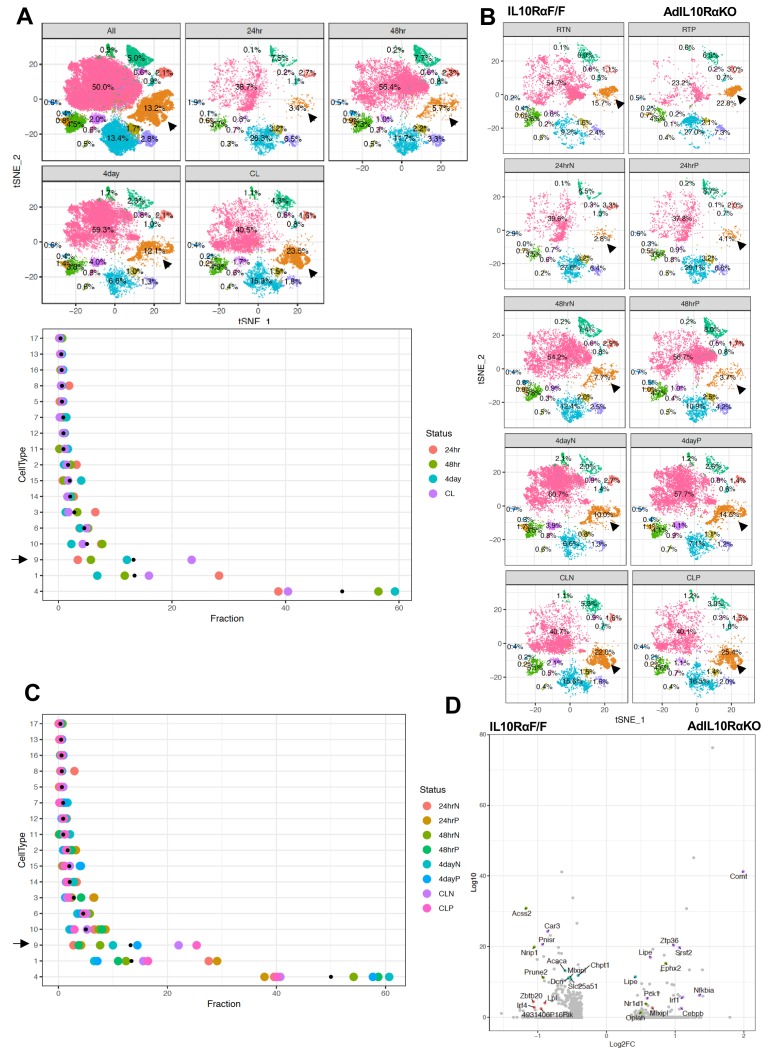
Enrichment of the thermogenic adipocyte cluster in IL10Rα-depleted mice.(A) Top: tSNE-plot showing percentage of clusters from aggregated (All) or from indicated treatments. Bottom: Colored dot plot showing percentage of fractions plotted in y-axis and cell types in x-axis under indicated conditions. (B) tSNE-plot showing differences in percentage of clusters between adipocytes from iWAT from control and AdIL10Rα KO mice under RT, 24 hr, 48 hr or 4 days cold exposure, or CL treated conditions. (C) Colored dot plot showing percentage of fractions plotted in y-axis and cell types in x-axis under indicated conditions and genotype. N deonotes Adipoq-Cre-Negative IL10RαF/F (IL10RαF/F) and P denotes Adipoq-Cre-Positive (AdIL10Rα KO) mice. (D) Volcano plot showing adipocyte gene expression differences between indicated mice from cluster 9. The Log2Fold Change (FC) ratio of floxed control vs. AdIL10Rα KO was plotted as a function of log10 p-value, with select genes indicated with text. Black arrow indicates the Type nine adipocyte cluster.